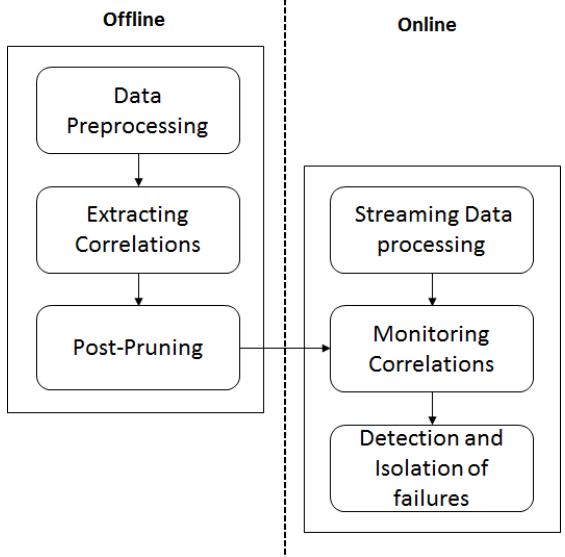
Figure 1. An overview of the proposed